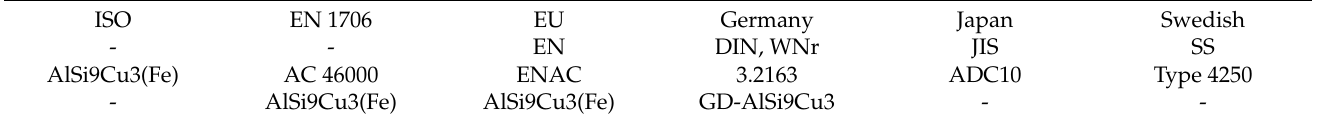
Table 2. AlSi9Cu3 alloy designation according to different